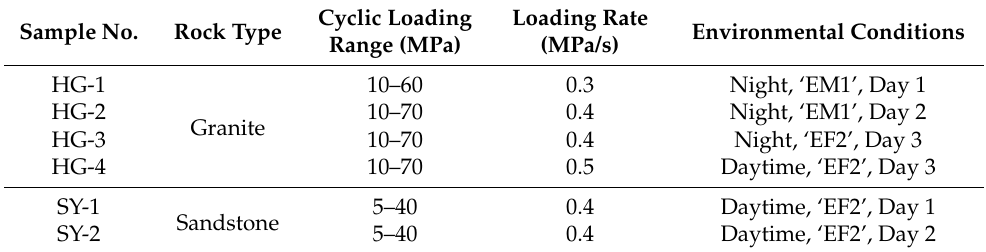
Table 1. The experimental parameters and conditions of the